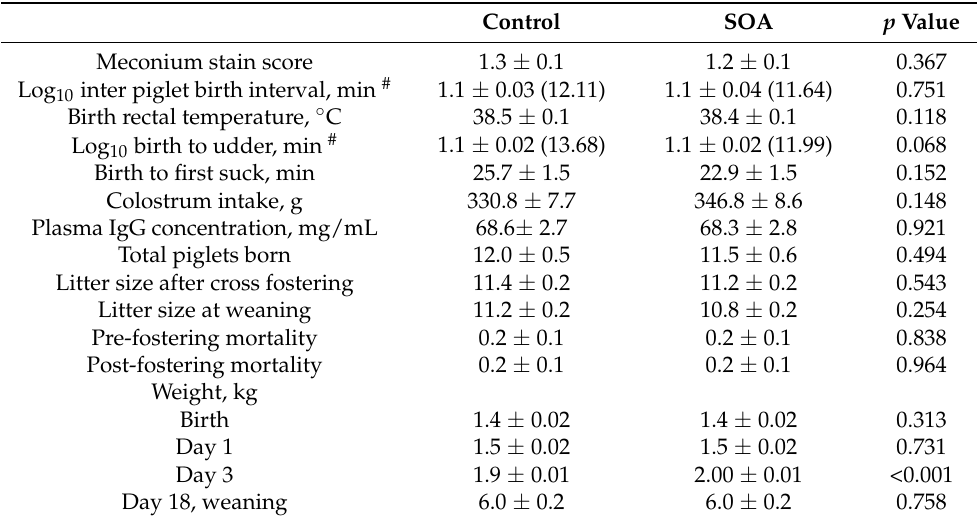
Table 1. Effect of the synthetic olfactory agonist (SOA) and Control treatments on piglet measure- ments (mean ± SEM).